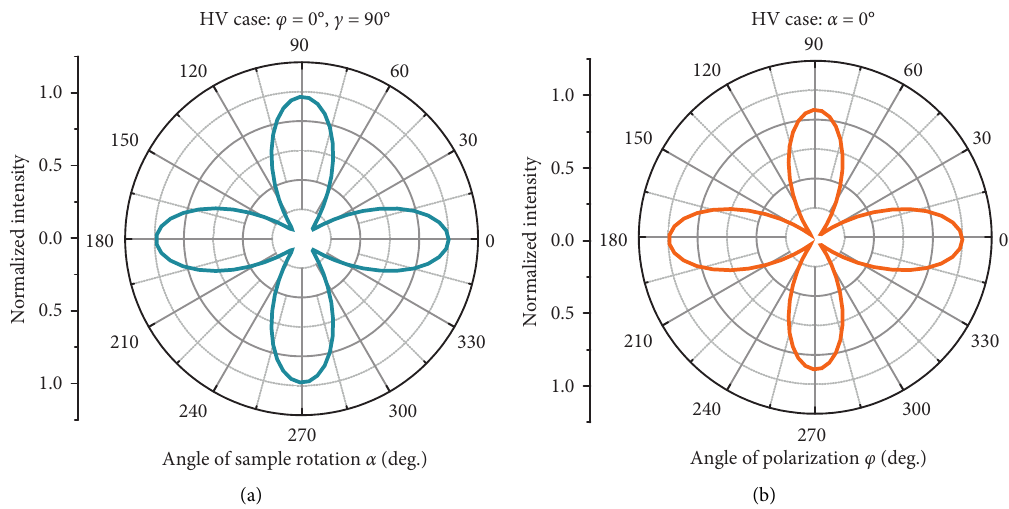
Figure 11: Intensity distributions of Raman modes in the HV case under the oblique backscattering configuration ( β � 30 ° ) for (a) a fixed polarization direction φ � 0 ° but a rotated sample rotation angle α and (b) a fixed sample rotation angle α � 0 ° but a rotated polarization direction φ ( c � φ +90 ° ).